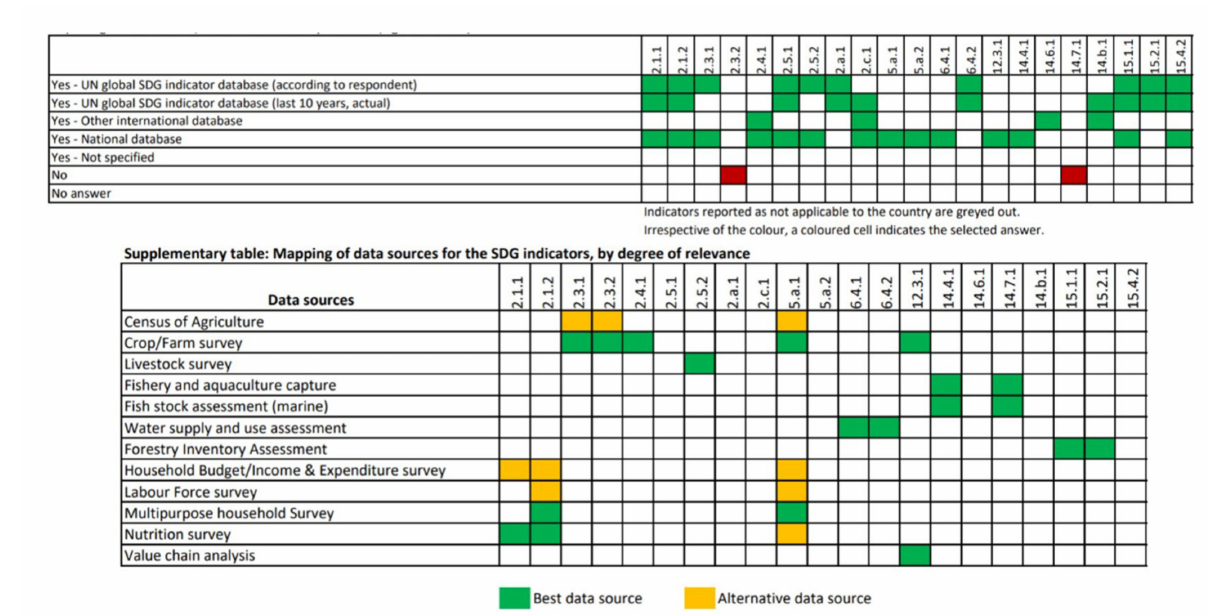
Figure 3. The statistical capacity for Ireland’s SDG Indicators (reporting and database sources), according to FAO’s statistical capacity assessment